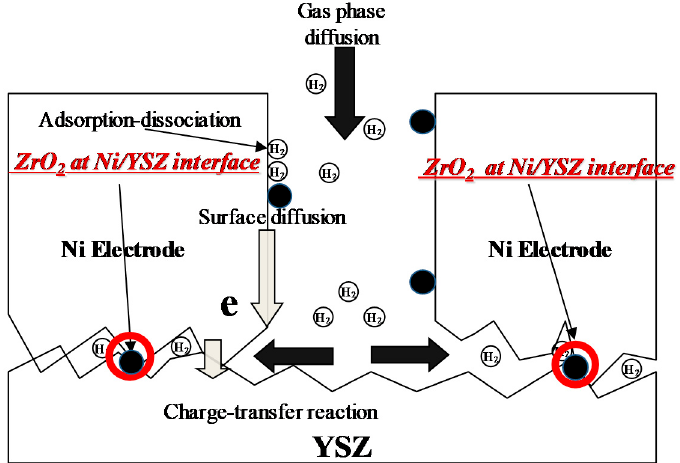
Figure 12. ( a ) Open cell voltages of reference cells and ZrO 2 ALD cells, ( b ) maximum power of reference cells and ZrO 2 ALD cells.